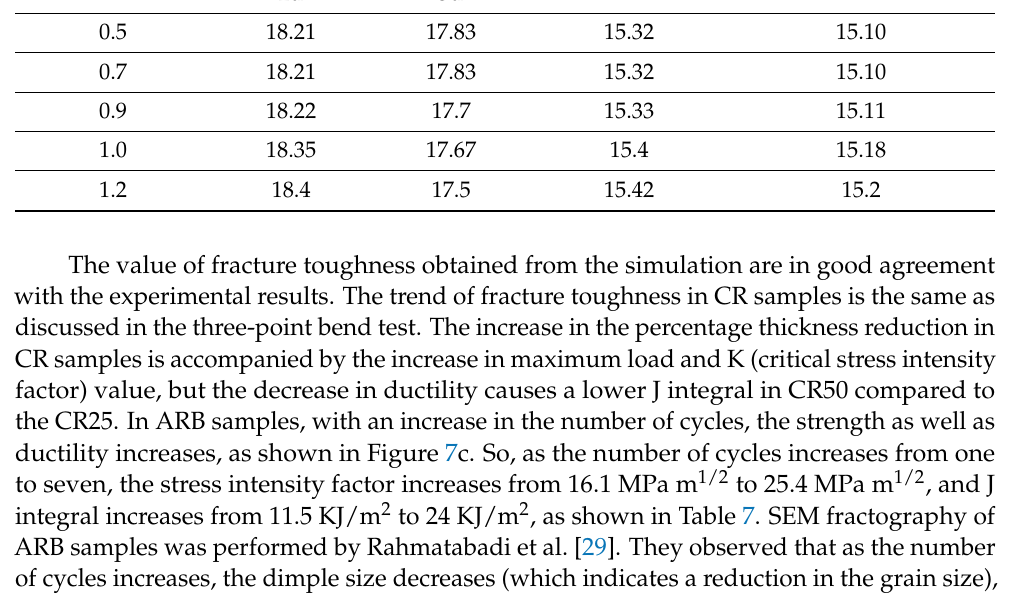
Table 7. Comparison of experimental and simulated results in CT, Center cracked, and double edge cracked specimen.